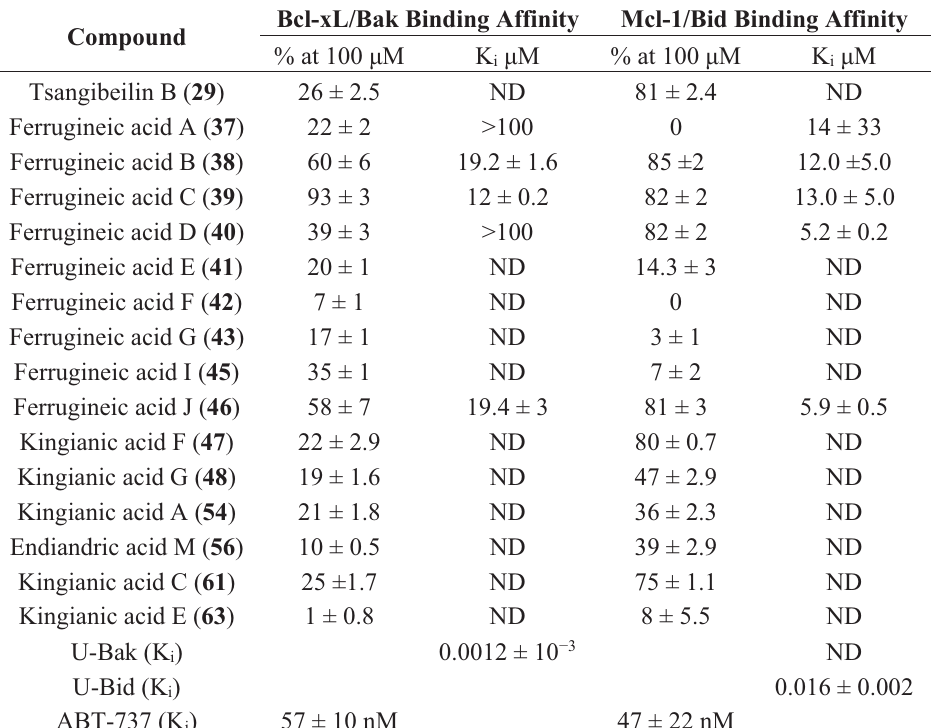
Table 5. Binding affinities of some endiandric acid derivatives to antiapoptotic proteins Bcl-xL and